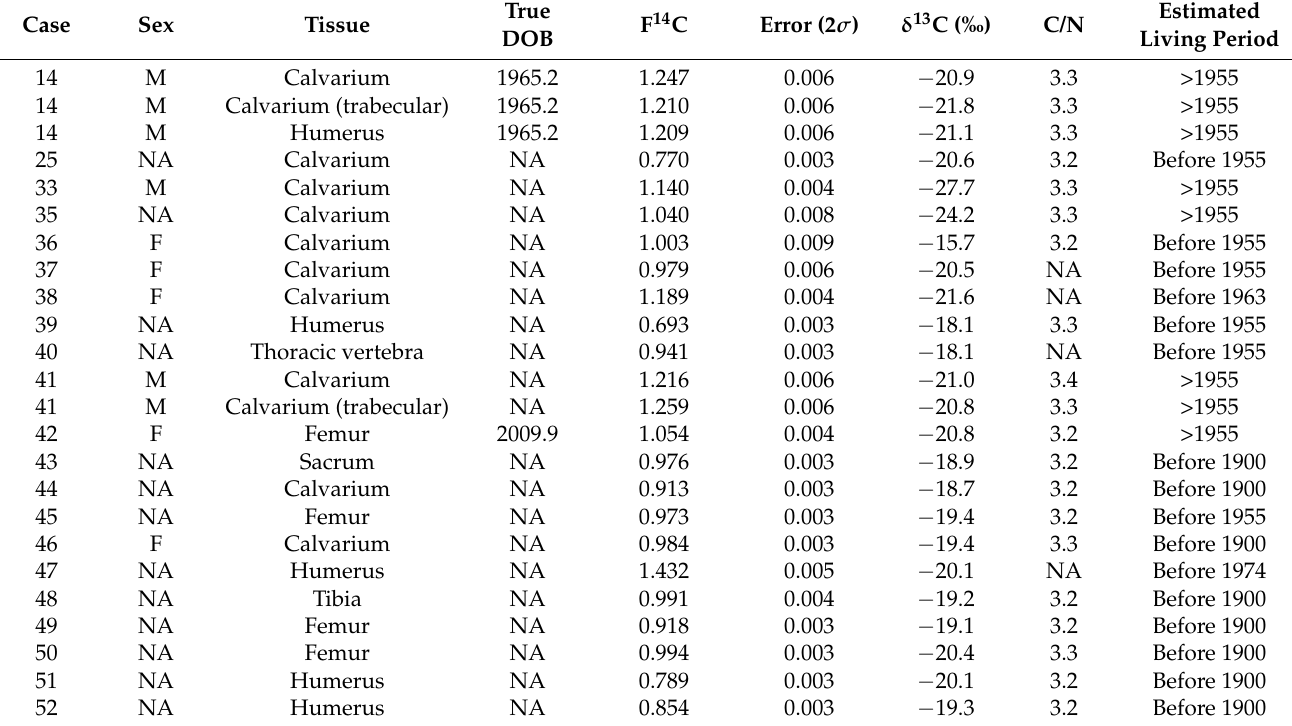
Table 3. AMS F 14 C results for the bone samples. Levels above 1.0 imply that the person was alive after 1955. All values below 1.0 indicate that the person either was not alive after 1955 or died soon after that. All values represent analysis of